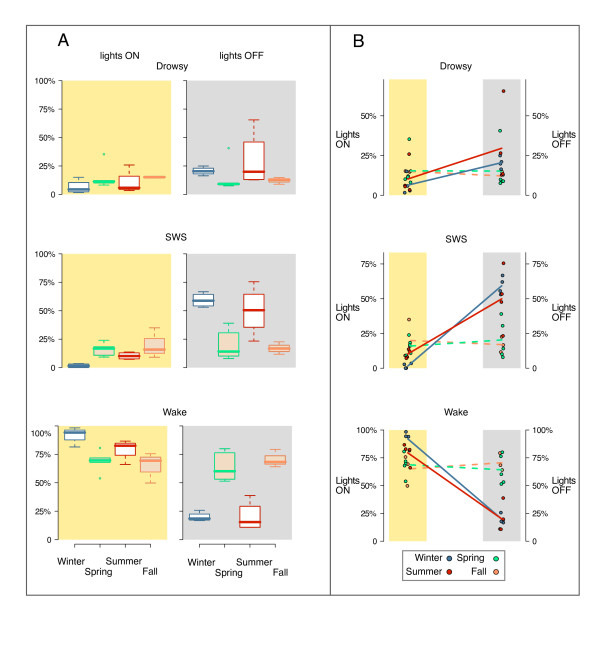
States of vigilance as a function of light and dark. Figure 3A. Box-and-whisker plots comparing percentage of time spent in each vigilance state: Drowsy, Sleep (SWS+REM) and Wake across the seasons, plotted separately for light (yellow background) and dark (gray background). Horizontal lines within boxes denote medians (50th percentile); horizontal edges of the boxes denote the 25th and 75th percentiles; whiskers extend to the 5th and 95th percentiles. Open symbols show the outliers. Figure 3B. States of vigilance as a function of light and dark in the four seasons. The percentage of time in each state is shown (colored circle) for each bird in the light (yellow background) and in the dark (gray background). The seasonal average of all birds is plotted at the endpoints of the lines. Lines highlight the change in vigilance state expression from light to dark during winter (blue) and summer (red), and the relative lack of change in spring (green) and fall (brown). Note that the length of the dark period varies with the season so equal percentages do not reflect equal times.